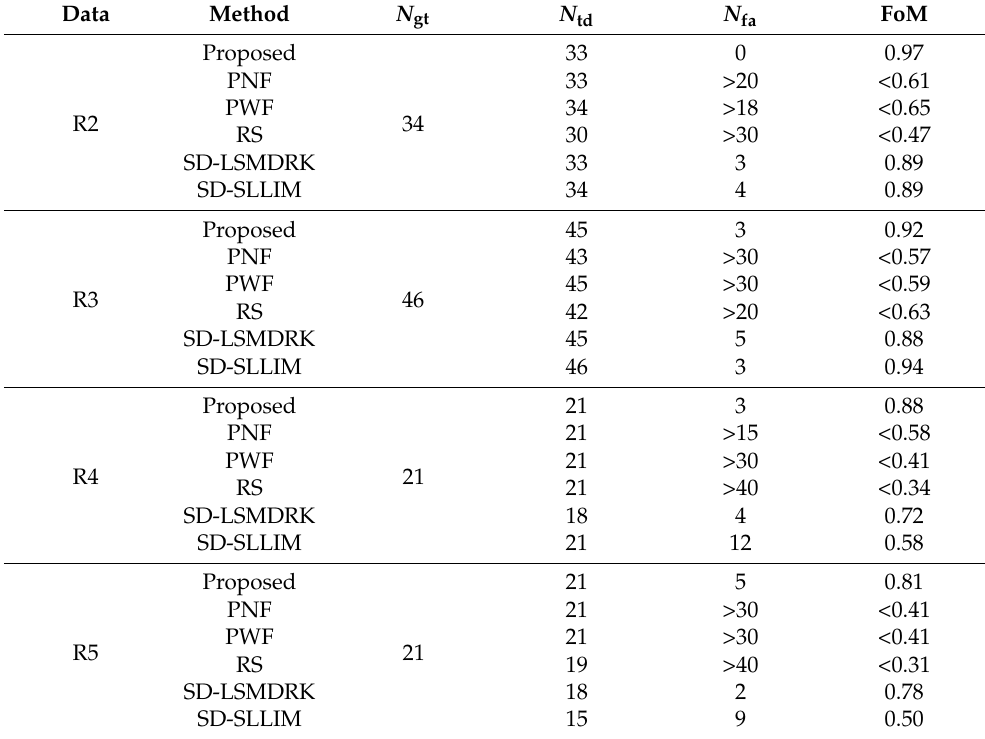
Table 4. Quantitative comparisons of different methods on